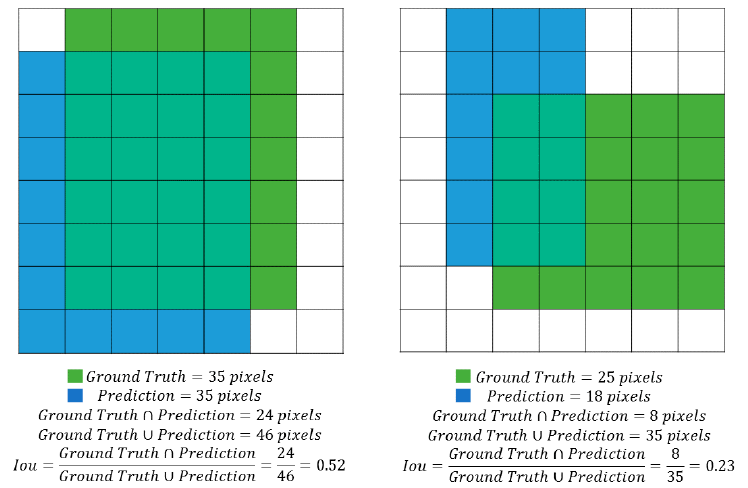
Figure 7. Evaluation of the IoU—Intersection over Union. This value is the ratio between the intersection and the union of the surfaces of the blue bounding box obtained by the classifier (Prediction) and the green one hand drawn during the ‘labelling’ process (Ground Truth). In ( a ) a sample image, in ( b ) a description of the calculation process.